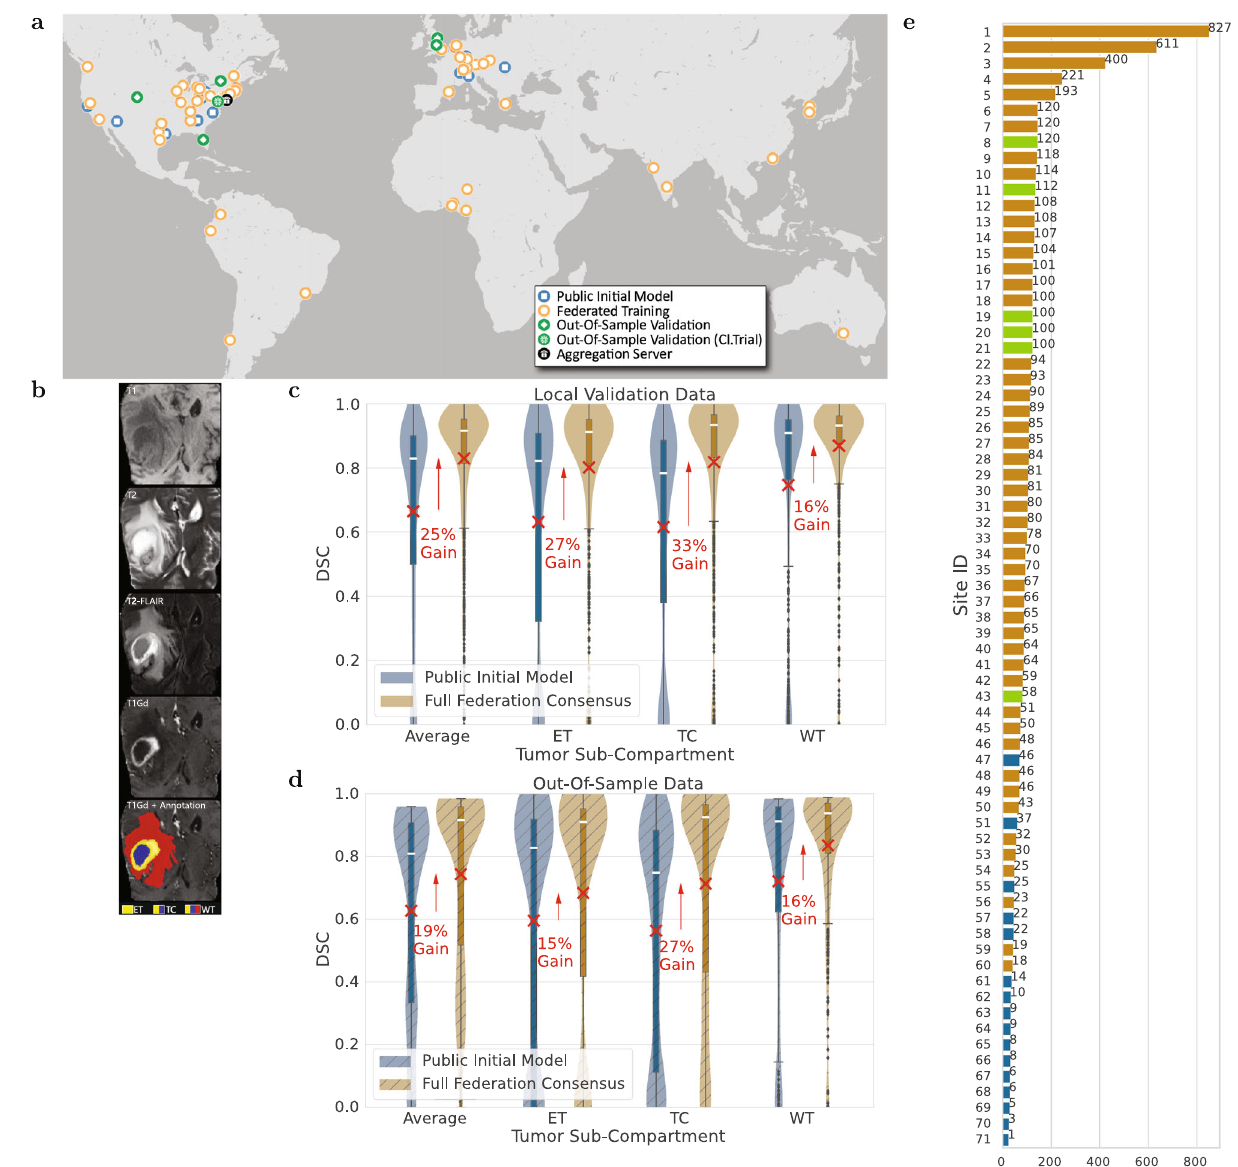
Fig. 1 | Representation of the study ’ s global scale, diversity, and complexity. a The map of all sites involved in the development of FL consensus model. b Example of a glioblastoma mpMRI scan with corresponding reference annota- tions of the tumor sub-compartments (ET enhancing tumor, TC tumor core, WT whole tumor). c , d Comparative Dice similarity coef fi cient (DSC) performance evaluation of the fi nal consensus model with the public initial model on the colla- borators' local validation data (in c with n =1043 biologically independent cases) andonthecompleteout-of-sampledata(in d with n =518biologicallyindependent cases), per tumor sub-compartment (ET enhancing tumor, TC tumor core, WT whole tumor). Note the box and whiskersinsideeach violinplot represent the true